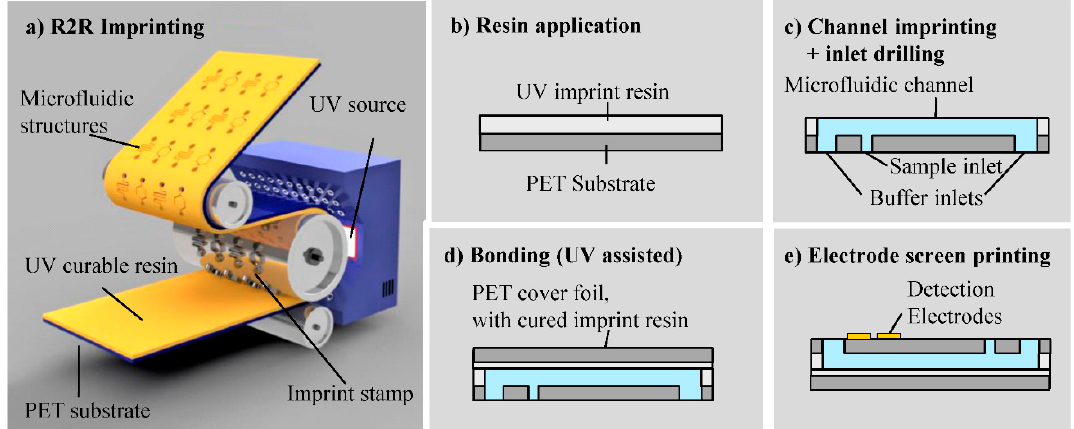
Figure 1. ( a ) Schematics of the R2R UV NIL process. ( b – e ) Process flow of capillary electrophoresis chip